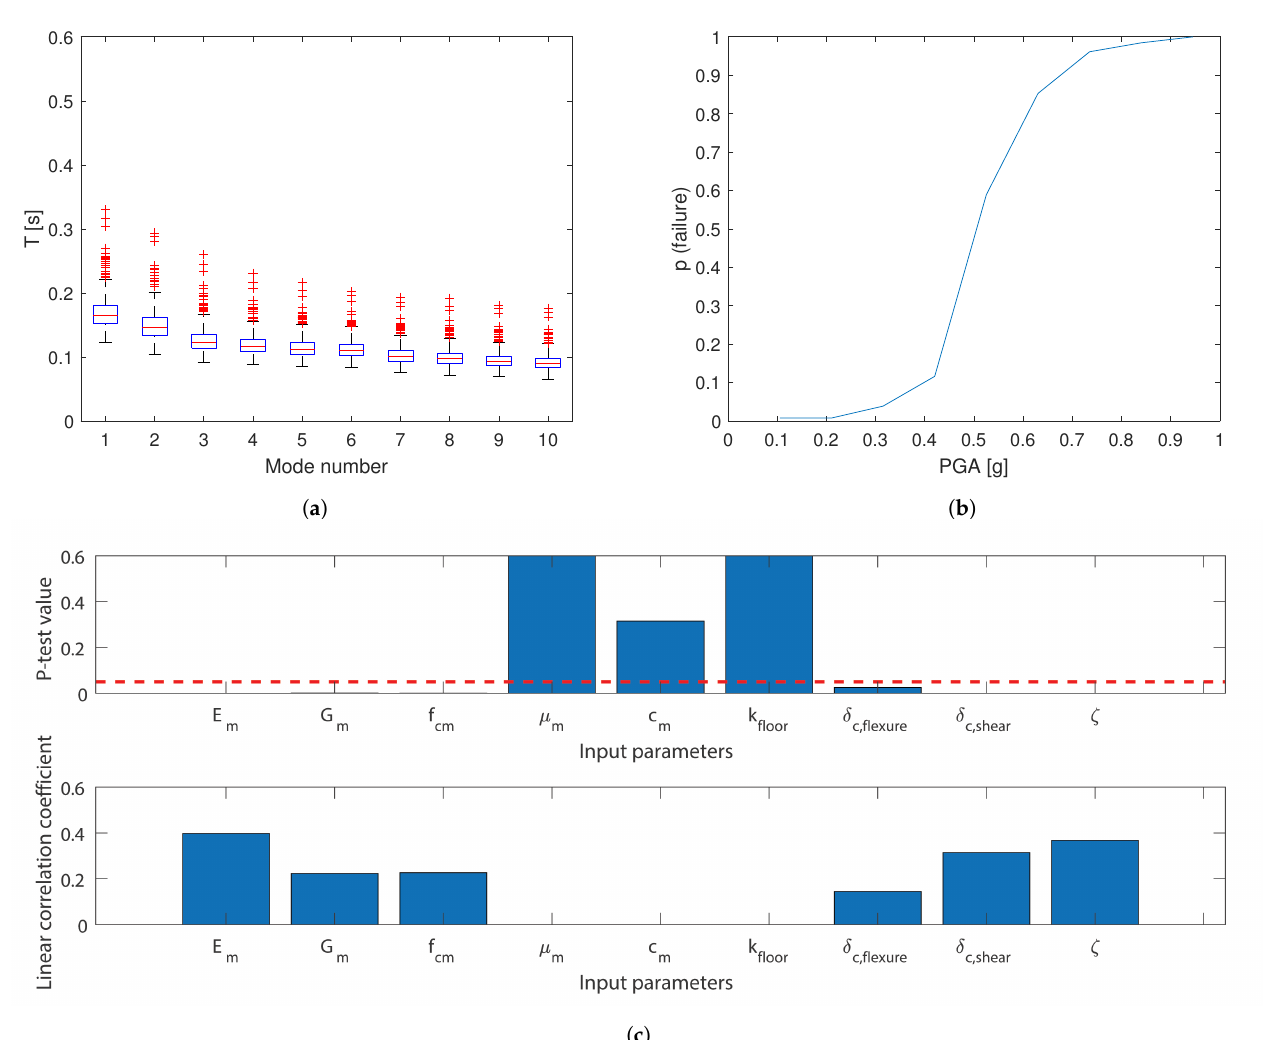
Figure 14. Holsteiner Hof model with out-of-plane disabled and rigid connections: ( a ) Distribution of modal periods. ( b ) Fragility curve. ( c ) Correlations between PGA at failure and input